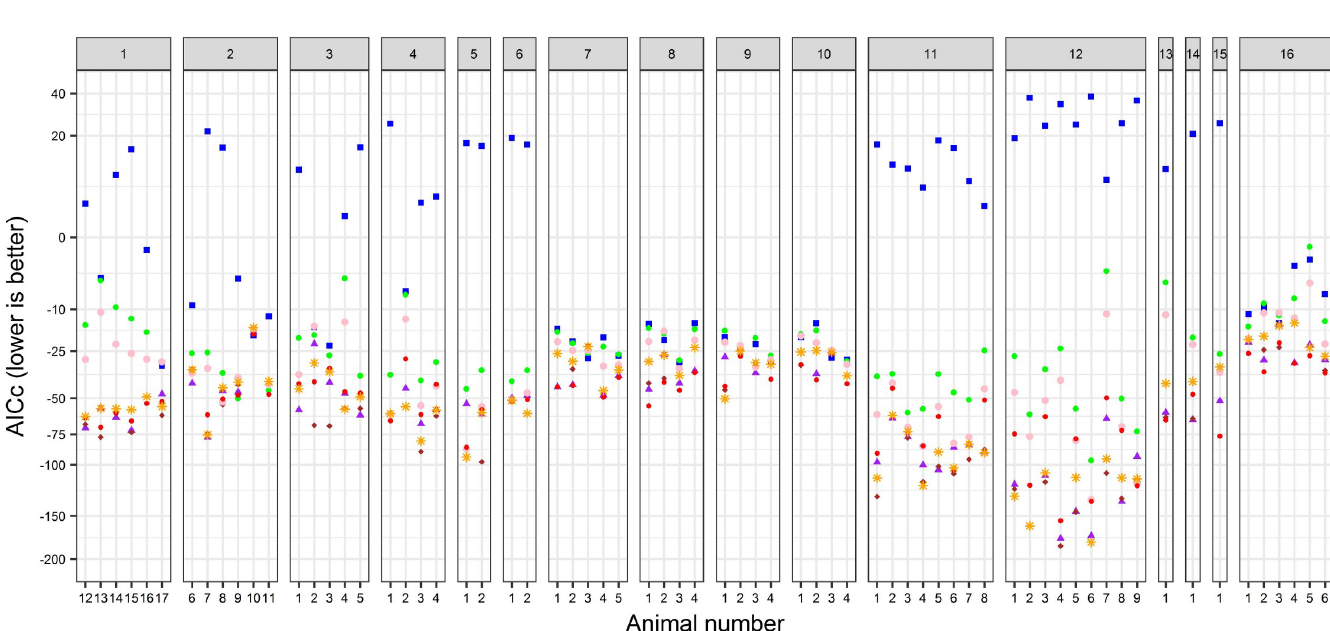
Fig 5. AICc values for the fit of each model to each of the 68 animals. Species groups are given in different panels with the label at the top. The legend for shapes and colors is the following: blue square = S1, green dot = S2, purple triangle = S3, purple diamond = S4, • = C2, red dot = C3, orange asterisk = MP.